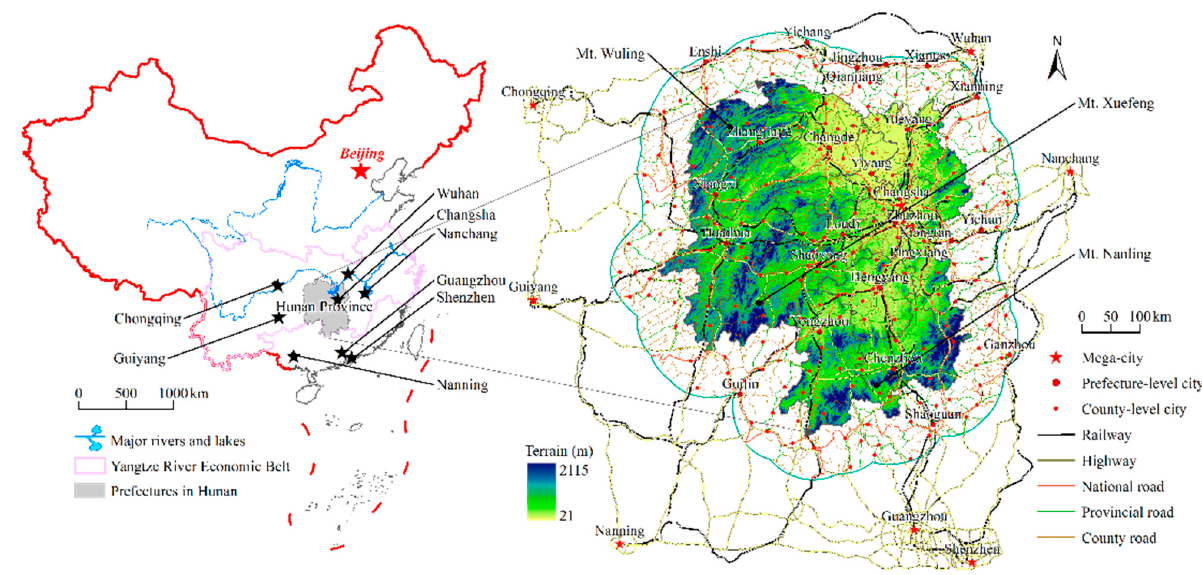
Figure 1. Location and traffic network of Hunan province and surrounding areas.